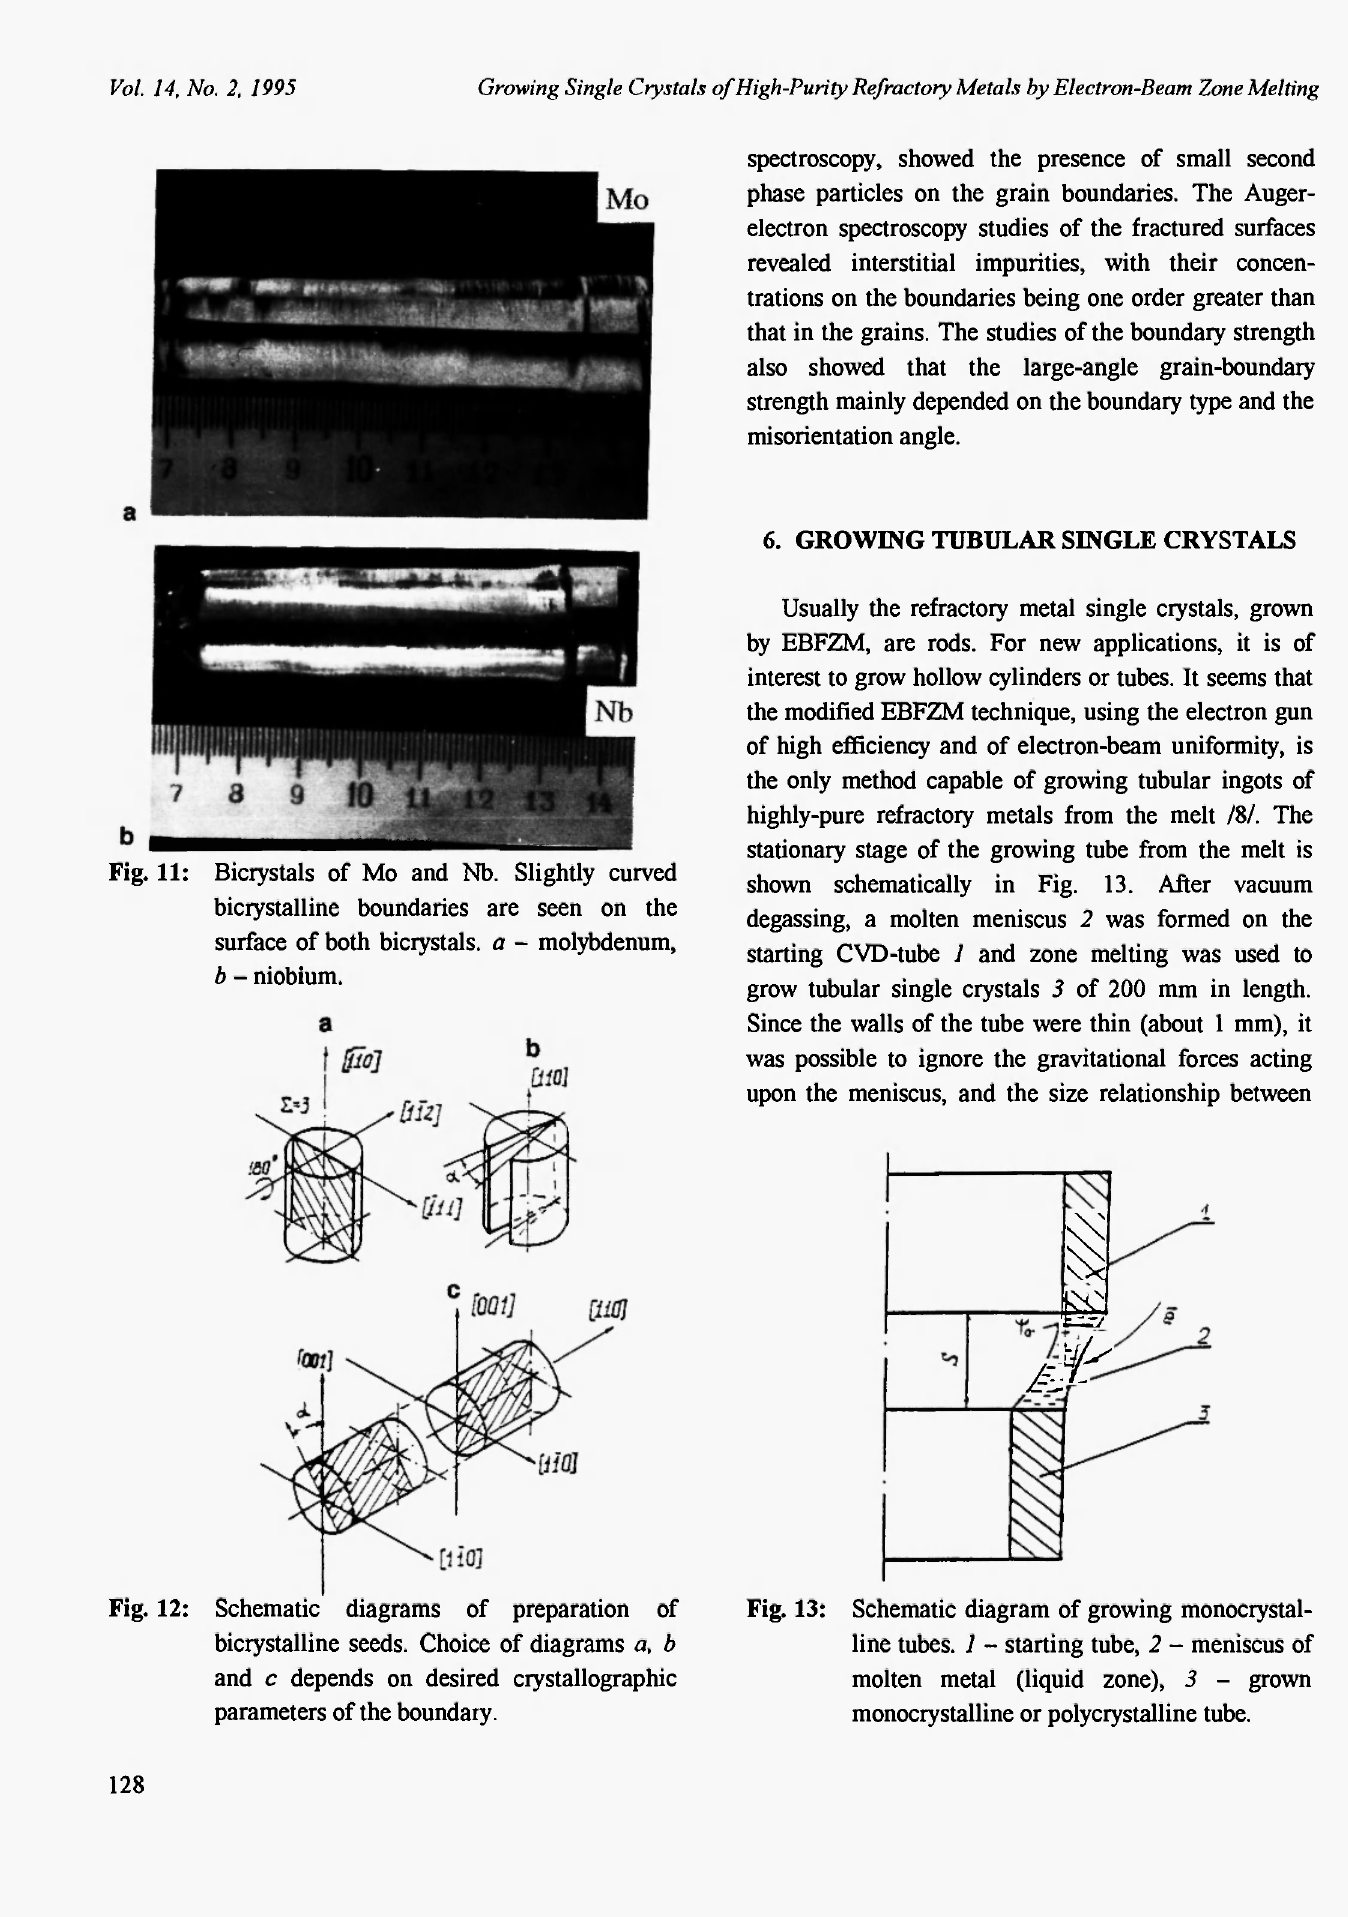
Fig. 12: Schematic diagrams of preparation of bicrystalline seeds. Choice of diagrams a, b and c depends on desired crystallographic parameters of the boundary.